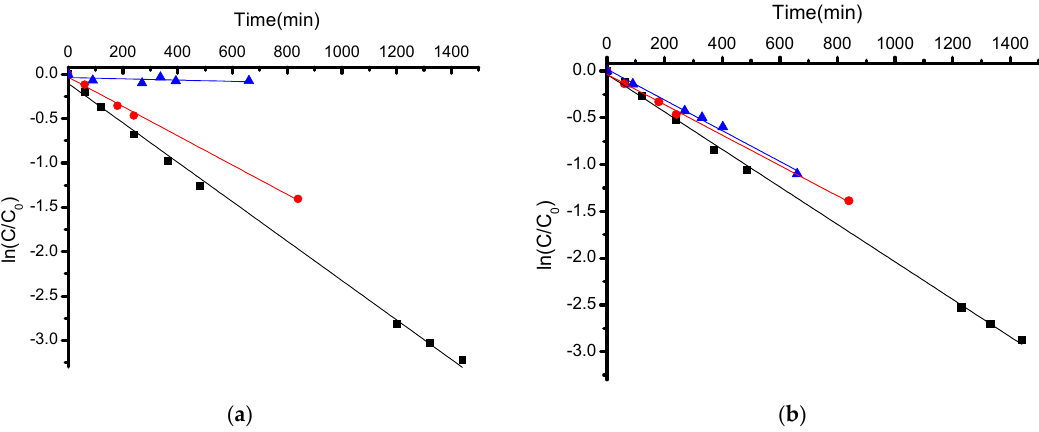
Figure 3. Time dependence of indium concentration in the feed solution for conventional PIM and PIMSD. ( b ) is the replot of the data of ( a ) in log scale, and the small figure in ( b ) is the magnification of the concentration change in the first 360 min. ▼ : conventional PIM with 1 M HCl as the strip solution; ￭ conventional PIM with 5 M HCl as the strip solution; ● : PIMSD with 5 M HCl as the strip solution.